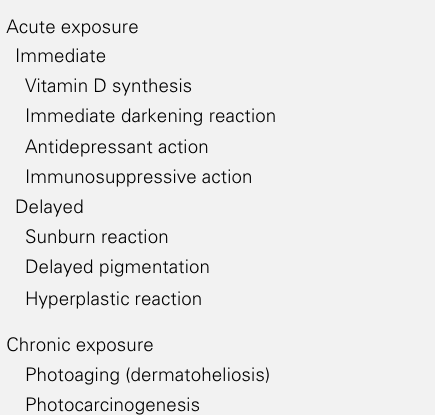
Table 1 - Effects of acute and chronic exposure to solar radiation.